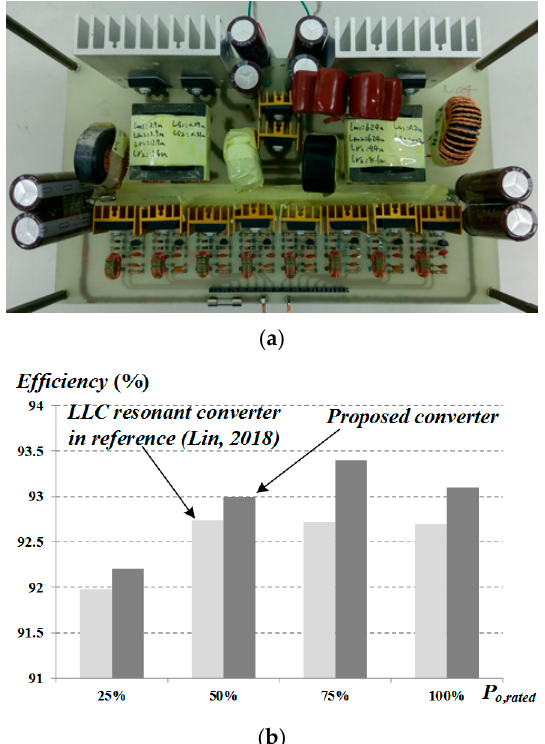
Figure 11. The picture and efficiency of the presented circuit ( a ) prototype circuit ( b ) circuit efficiency at 750 V input.